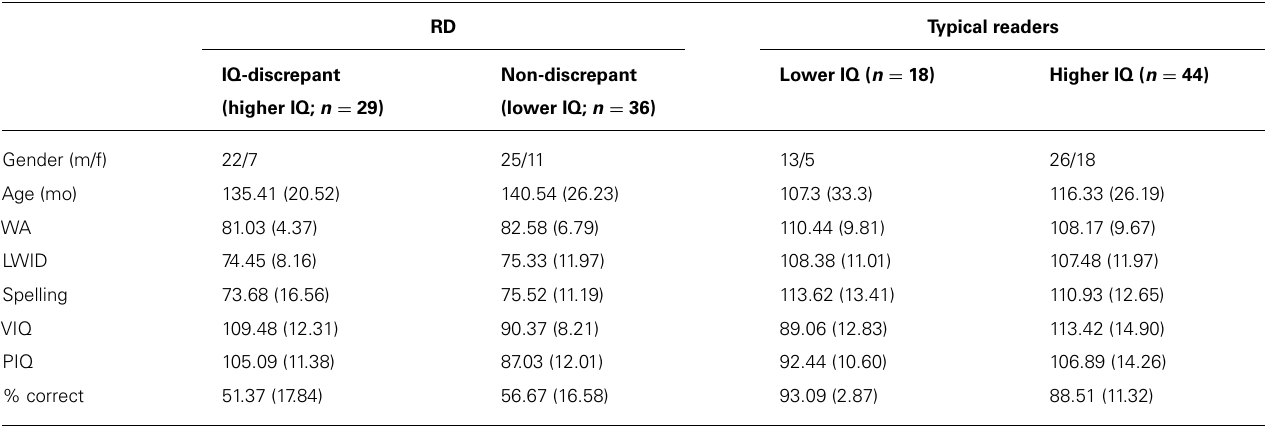
Table 1 | Demographic data and performance on standardized tests for each group of participants (mean and SD in